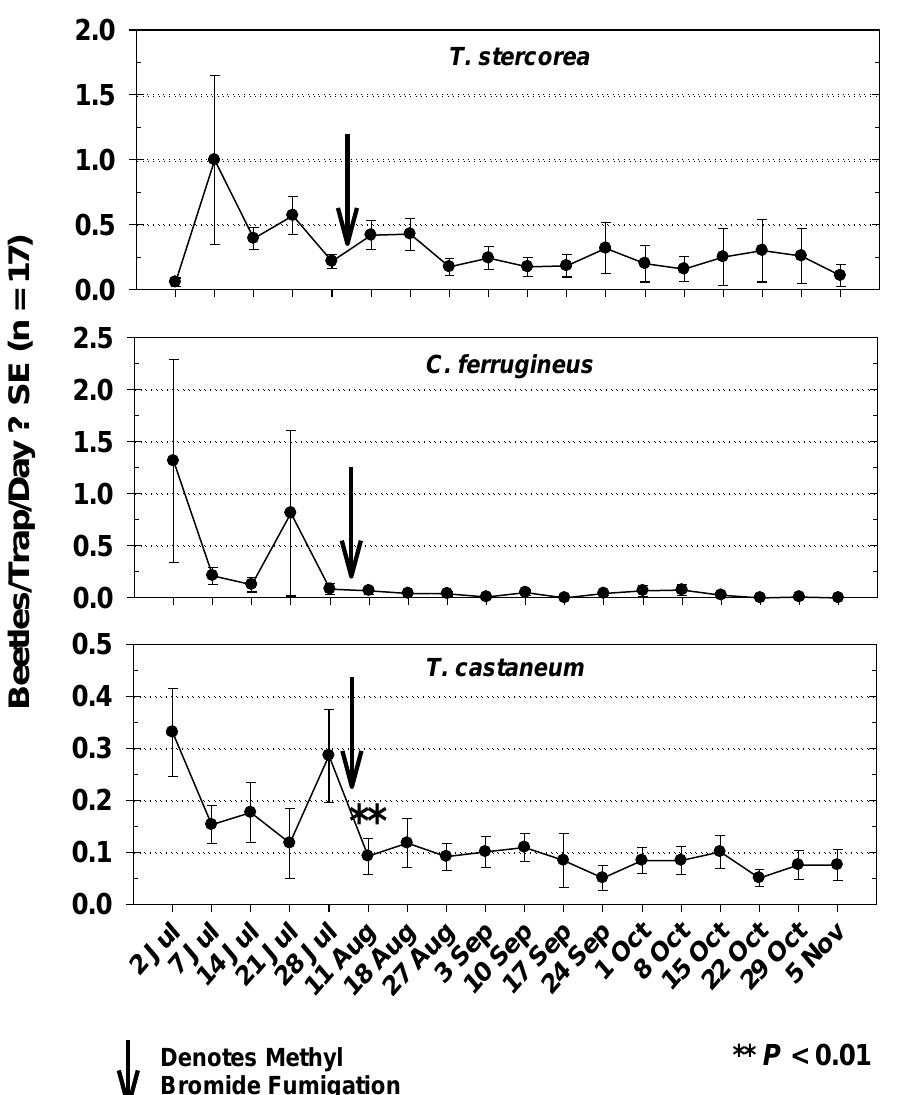
Figure 8. Capture of T. stercorea , C. ferrugineus , and T. castaneum throughout mill 2 during Year 2. Results are from weekly observations from 17 modified pitfall traps. Arrows denote methyl bromide fumigation on 1 August. Capture of T. castaneum was significantly lower following methyl bromide fumigation ( t = 3.88; df = 16; p = 0.0015; a ** signifies statistical significance after 1 August). Count data for t-tests were square root transformed.